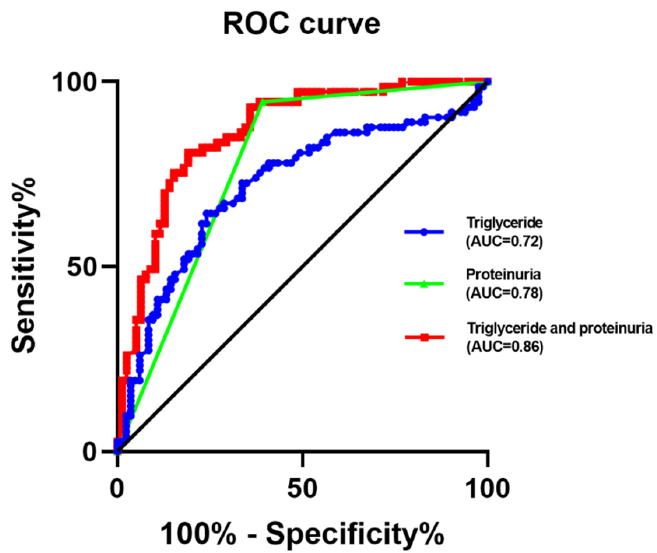
Figure 3. ROC curve analysis of triglycerides, proteinuria, and the combination between triglycerides and proteinuria to predict SLE-related kidney injury from SLE-no kidney injury. ROC: receiver operating characteristic. Table 6. The relationship between triglycerides and proteinuria in SLE-related kidney injury pa- tients.